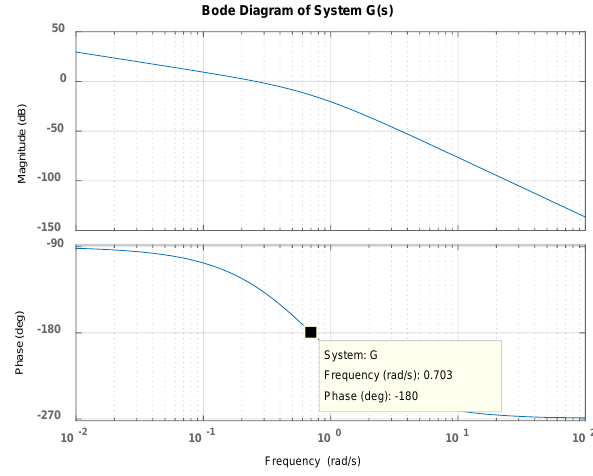
Figure 3. Frequency Response of the linear plant.